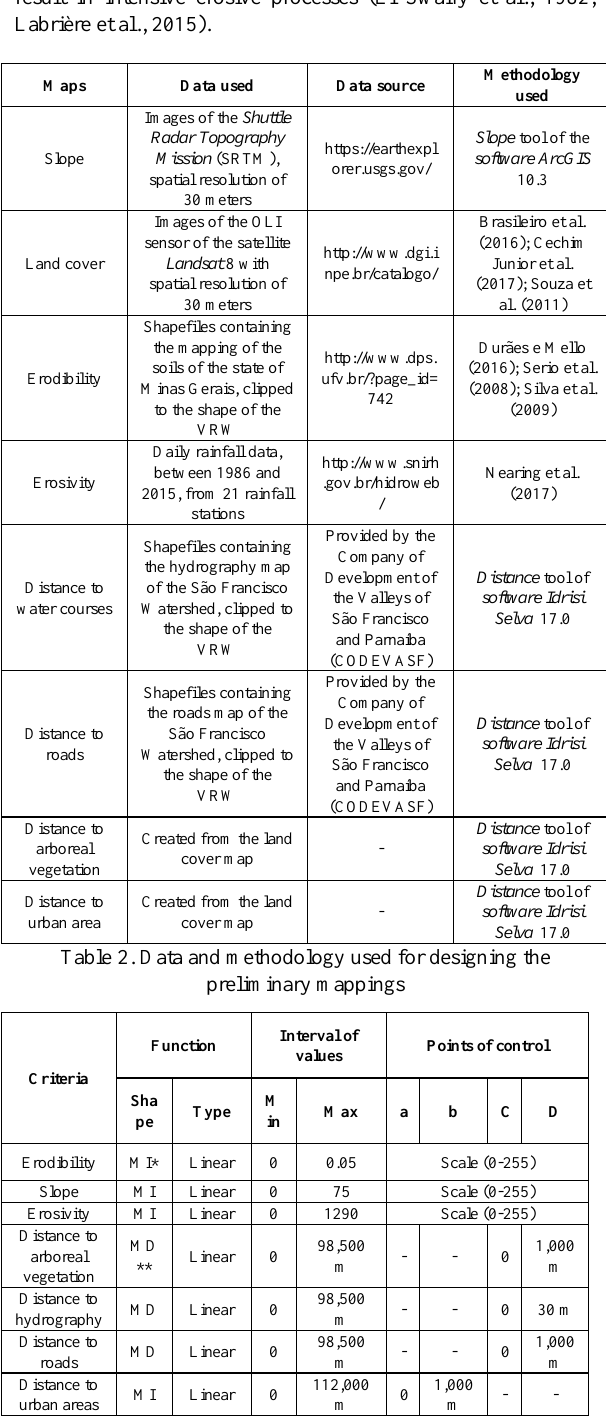
Table 3. Factors selected, functions chosen and values established to identify the priority areas for reforestation